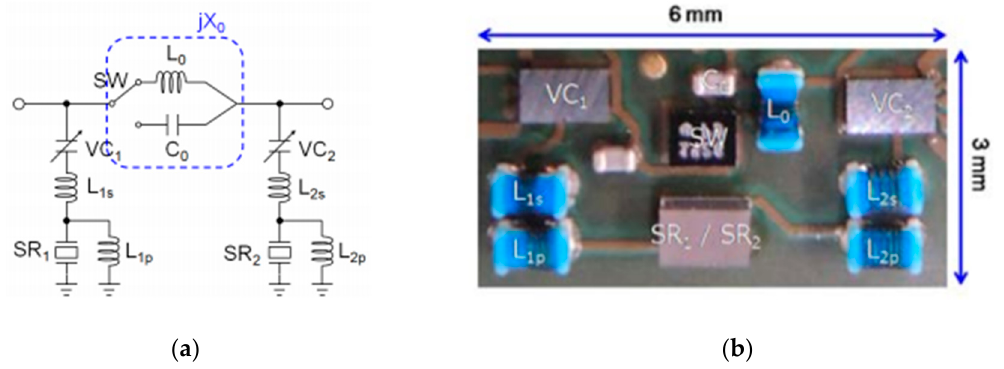
Figure 6. π type reconfigurable SAW filter: ( a ) Circuit configuration; ( b ) a top view of the fabricated filter [49].